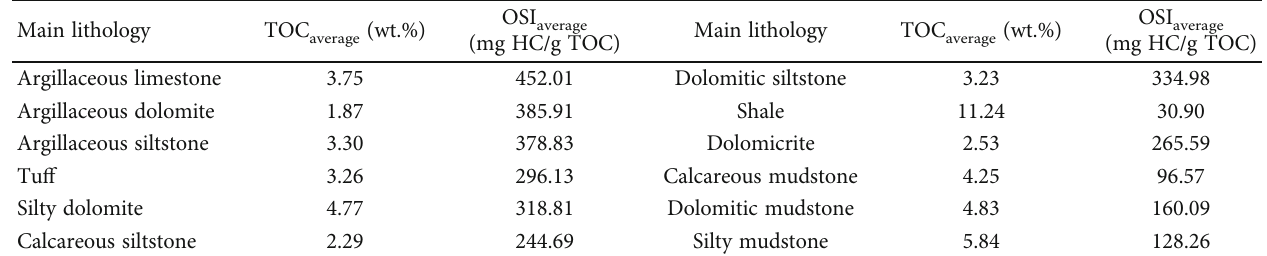
Table 2: Average TOC contents and OSI values of the main lithofacies in the sweet spots in the Lucaogou Formation, Jimusar Sag. Main lithology TOC (wt.%) average